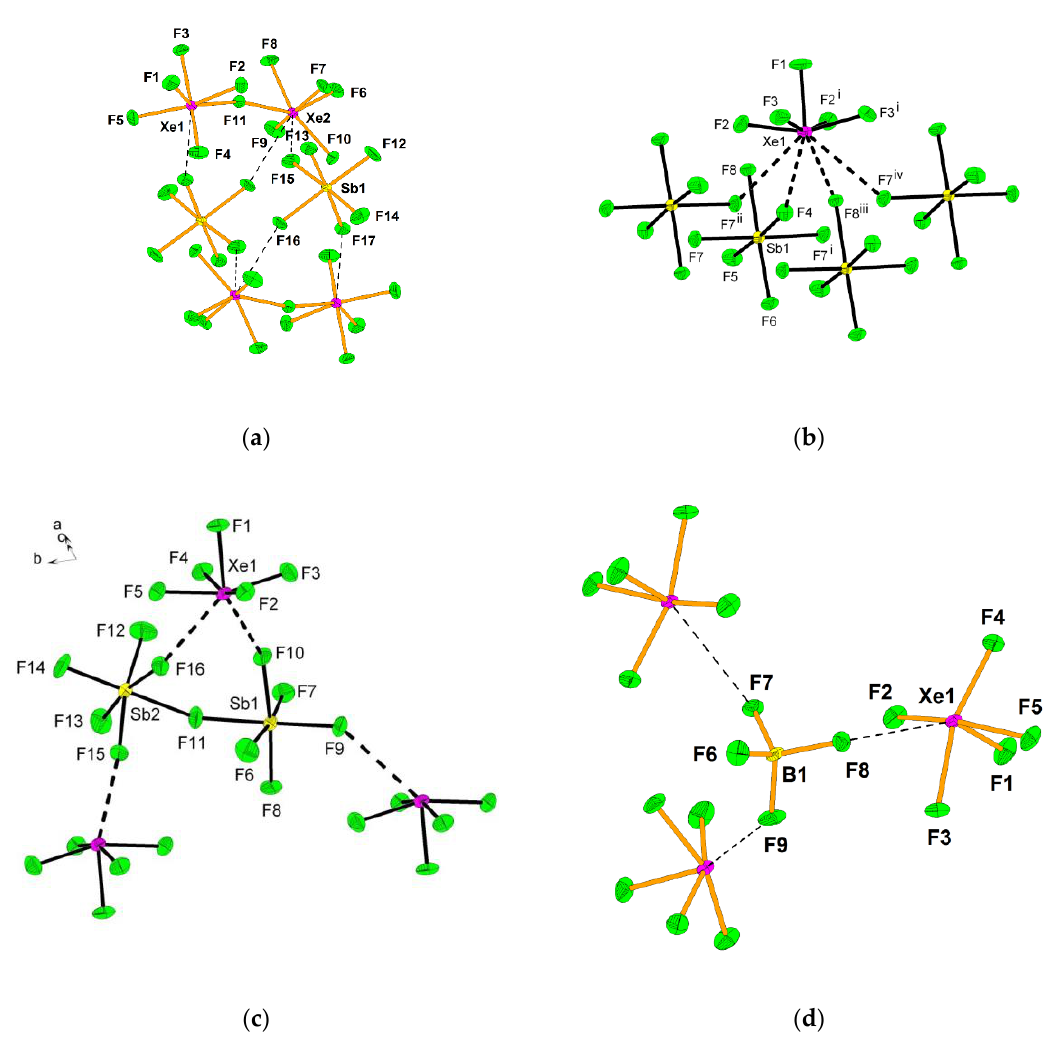
Figure 3. ( a ) Part of the crystal structure of [Xe 2 F 11 ][SbF 6 ]. Copyright (2017) Wiley. Used